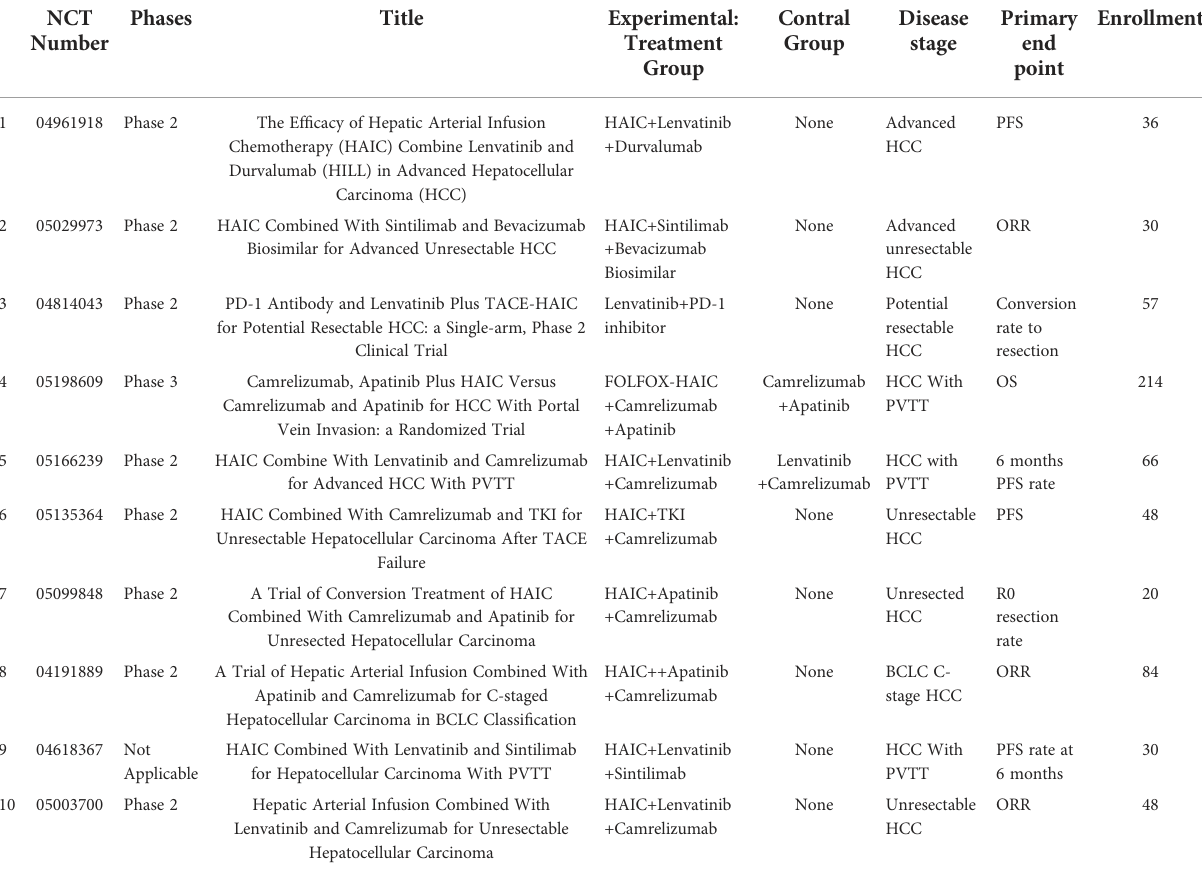
TABLE 6 Ongoing clinical trials for HCC patients with HAIC+TKIs+PD-1/PD-L1